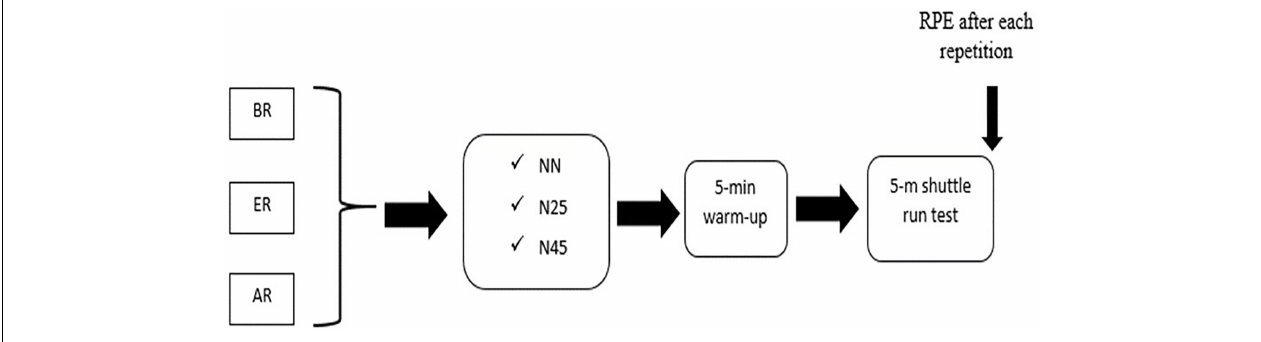
FIGURE 1 | Schematic representation of the experimental protocol. RPE: rating of perceived exertion; BR: ∼ 2 weeks before Ramadan; ER: last ten days of Ramadan; AR: ∼ 3 weeks after Ramadan; N25: 25-min nap condition; N45: 45-min nap condition; NN: no nap condition.